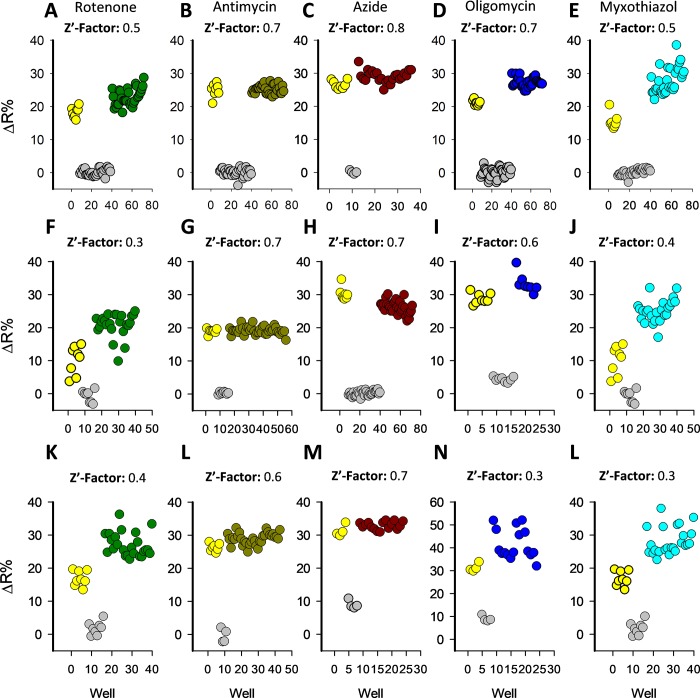
High throughput suitability characterization.The Z’-factor was calculated using wells treated with 32 μM rotenone, 16 μM antimycin, 5 mM azide, 80 μM oligomycin, and 10 μM myxothiazol as positive controls. Negative control wells were treated with 50 μM of pCMBS (gray circles) and nanosensor response control with 10 mM lactate (yellow circles). All the Z’-Factors were calculated at 10 minutes post-treatment. Experiments from three independent assays for each mitochondrial toxicant, performed on different experimental days.